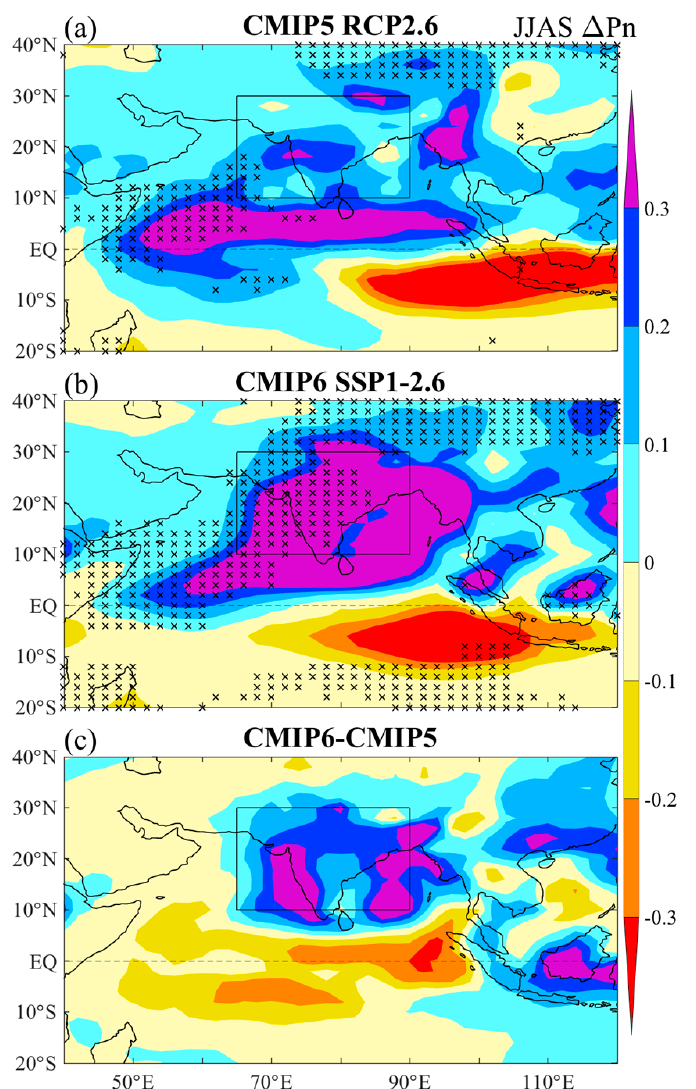
Figure 2. Normalized multi-model ensemble mean (MME) ISM precipitation change (JJAS ∆ Pn, mm day -1 ) ( a ) under RCP2.6 in CMIP5, ( b ) under SSP1-2.6 in CMIP6 and ( c ) their difference. The black cross indicates at least 2/3 models show the same sign with MME results. The domain for calculating area-mean ISM precipitation is 65–90 ◦ E and 10–30 ◦ N, indicating by the black box. As surface specific humidity is not available in some models, the vertically integrated water vapor through the atmospheric column ( prw ) can be used to replace q s based on the approximation below: